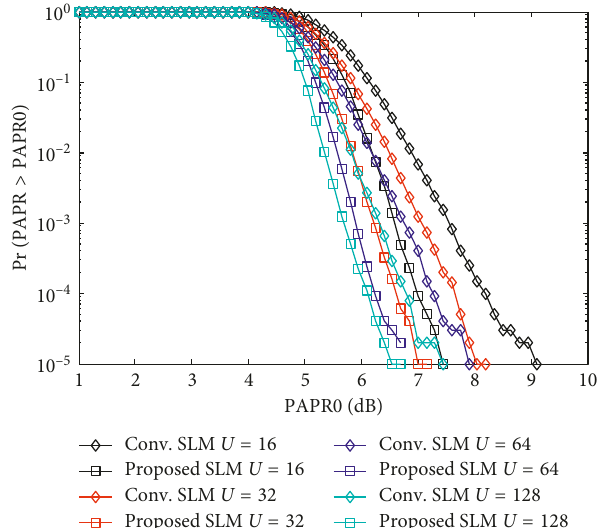
Figure 7: Comparison of SLM given in [5] with the proposed SLM for U � 16, 32, 64, and 128, N � 64, and 4-PSK.